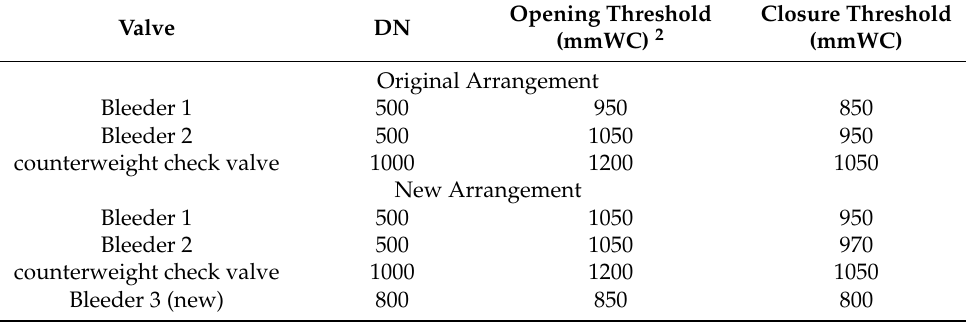
Table 2. Opening and closure threshold of the bleeders in the original system and in the new